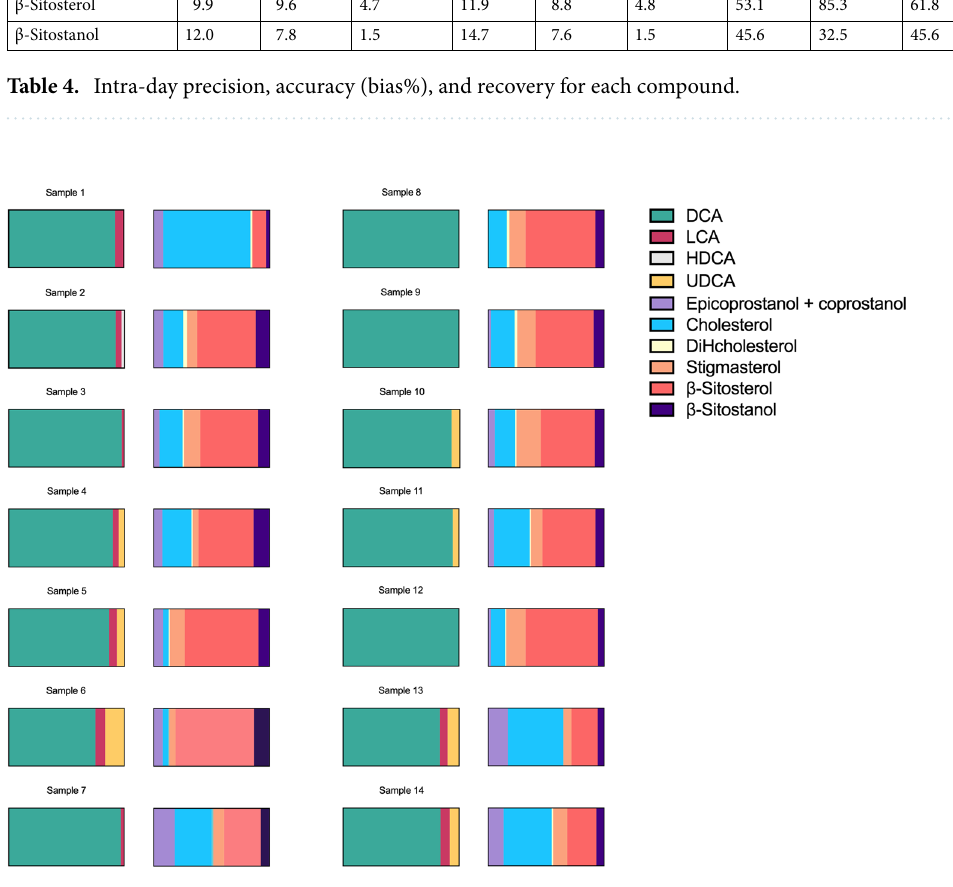
Figure 5. Results in % of BAs and steroids in soil samples 1–7 from the 2020 and 8–14 from 2021 excavation campaigns displayed as part of